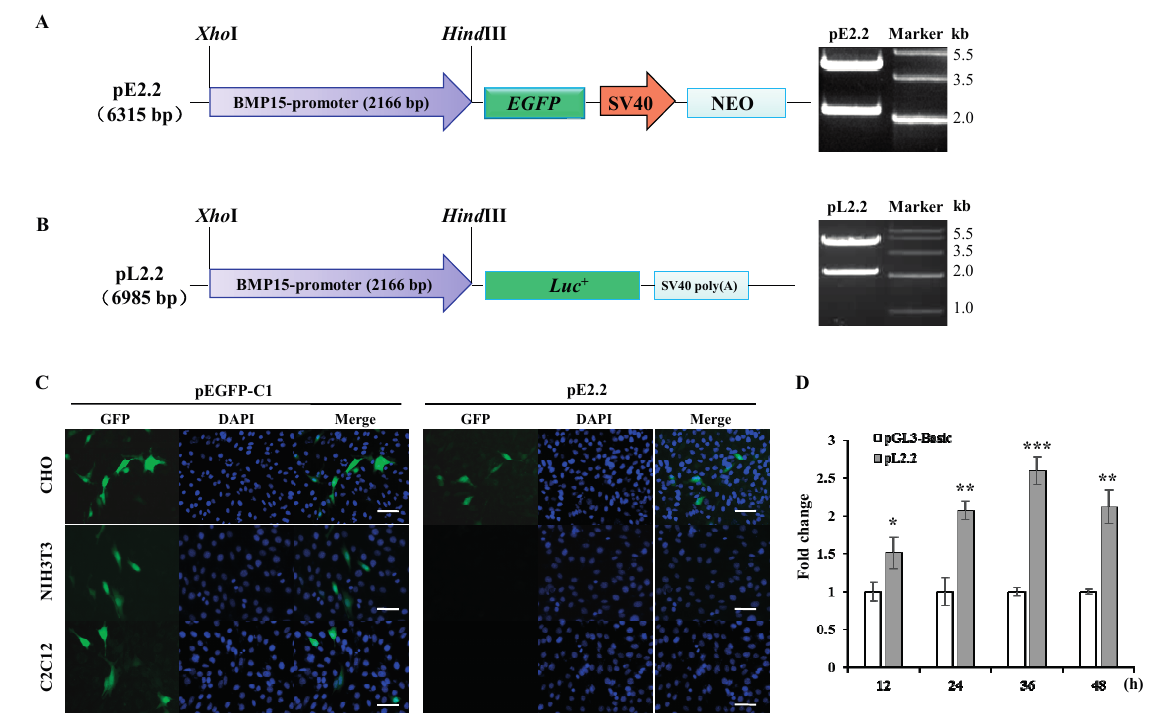
Figure 2. Functional analysis of cloned porcine BMP15 promoter. ( A ) Reporter vector pE2.2 is derived from pEGFP-1 vector and contains 2.2 kb BMP15 promoter fragment that is confirmed by Xho I /Hind III digestions; ( B ) Reporter vector pL2.2 is derived from pGL3-basic vector and contains 2.2 kb fragment confirmed by Xho I /Hind III digestions; ( C ) Cell-specific activation of BMP15 promoter in different cell lines. Scale bar, 100 μ m; and ( D ) Time-dependent luciferase assay for BMP15 promoter activity in CHO cells. The pGL3-Basic vector was used as control. Values are represented as mean ± SD, * p < 0.05, ** p < 0.01, *** p < 0.001, n =